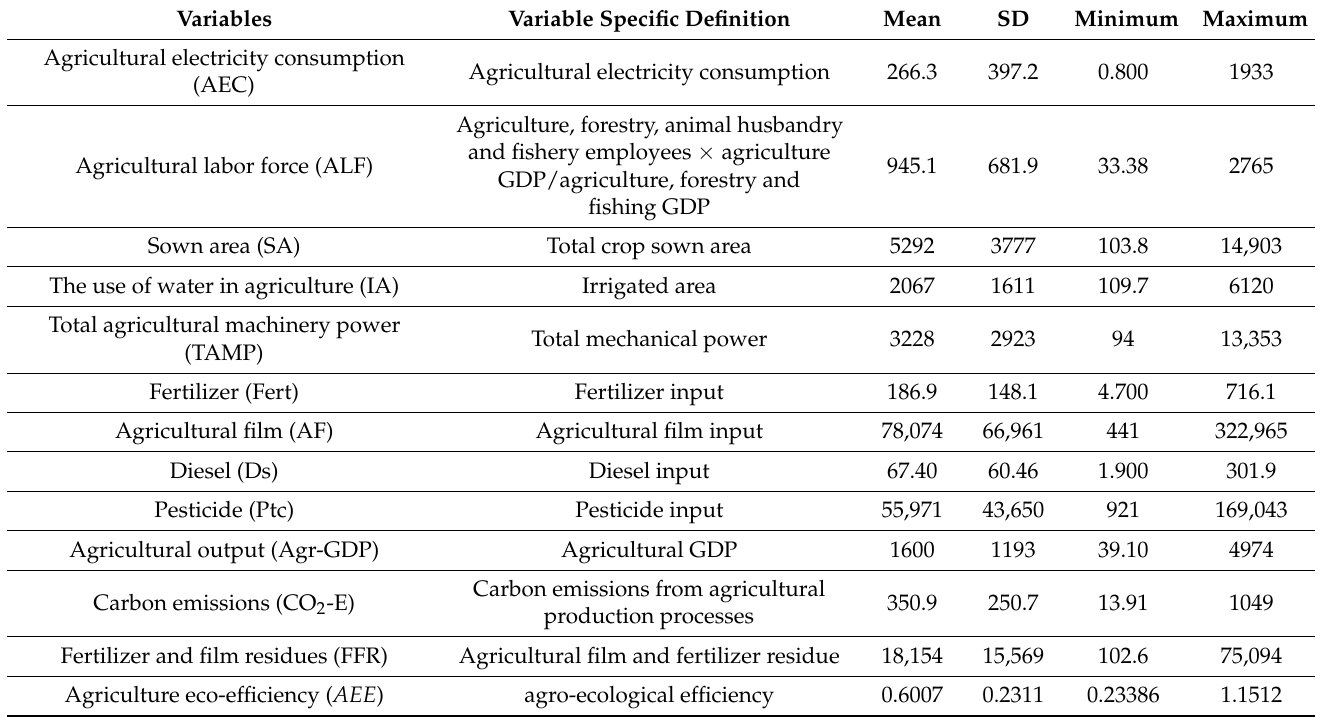
Table 1. Descriptive statistical